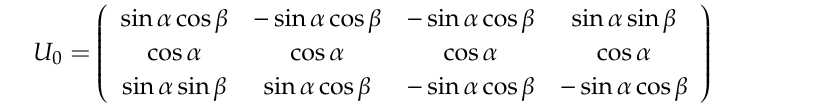
Table 4. Hot backup gate SHA with the continuous variable motion law h Γ .